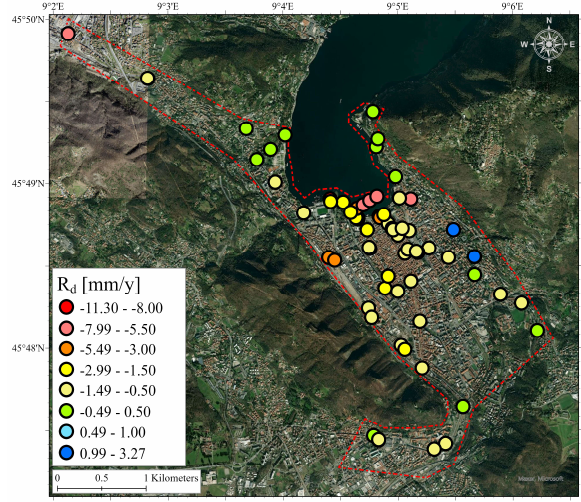
Figure 3. vertical ground deformation rate R d (in mm/year) for the period of 1997-2004 at 85 available levelling